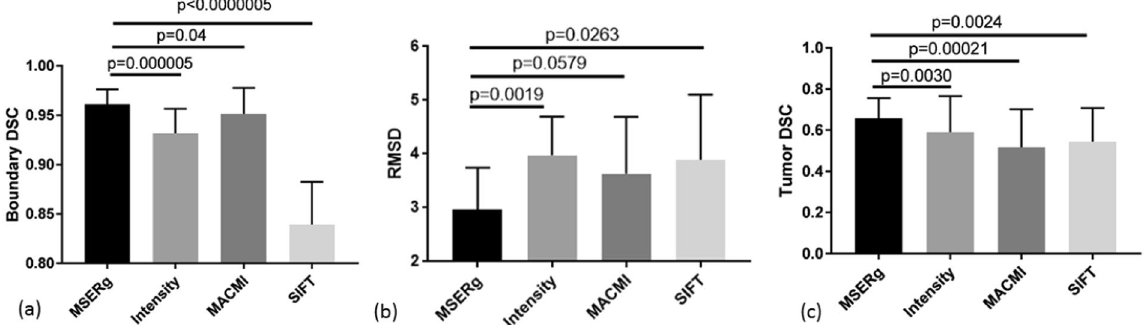
Figure 4. MSERg, MACMI, SIFT and Intensity-based Registration comparison in terms of prostate capsule boundary DSC, landmark RMSD and tumor DSC with statistical significance analysis testing on the clinical test set. Greater DSC value and lower RMSD indicate better annotation alignment and thus a better registration result. Statistical significance testing was performed between each pair of methods with respect to MSERg in terms of capsule boundary DSC, landmark RMSD and tumor DSC. In 8 of the 9 different comparisons performed, MSERg statistically significantly (p < 0.05) outperformed the other methods for the cases in the clinical test